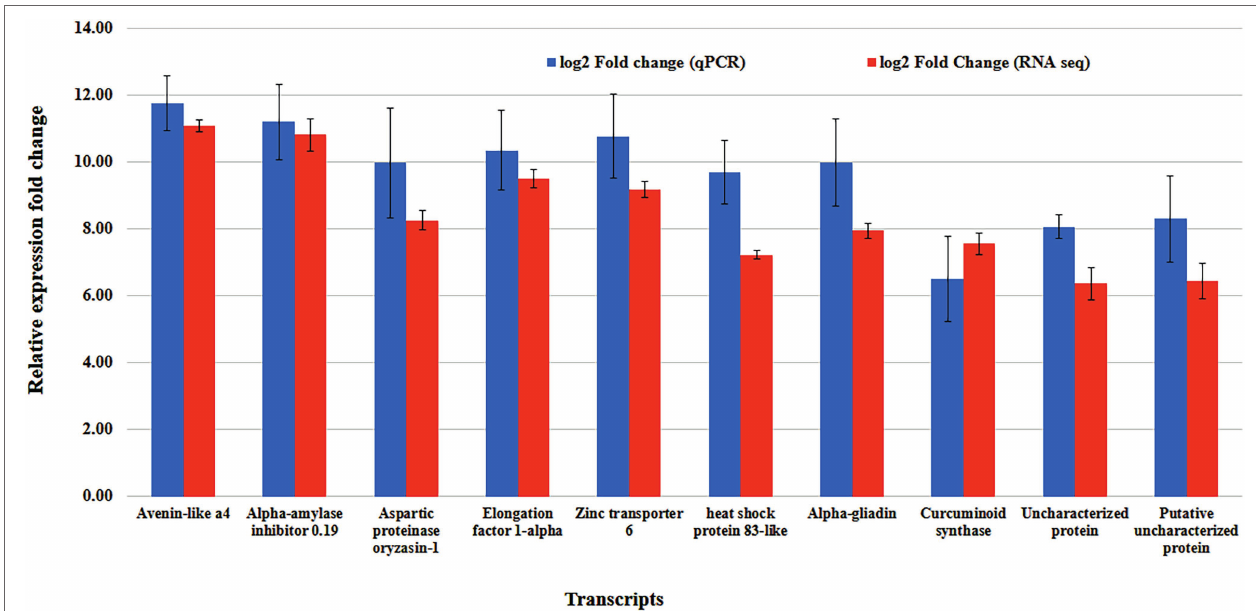
FIGURE 8 | Comparative expression analysis of selected DEGs using RNA-seq and qPCR. Data are means of two independent biological replicates ( p ≤ 0.05, n = 2). Error bars represent the means ± SD ( n = 2). Accuracy of the RNA-seq data getting confirmation with the qPCR expression pattern